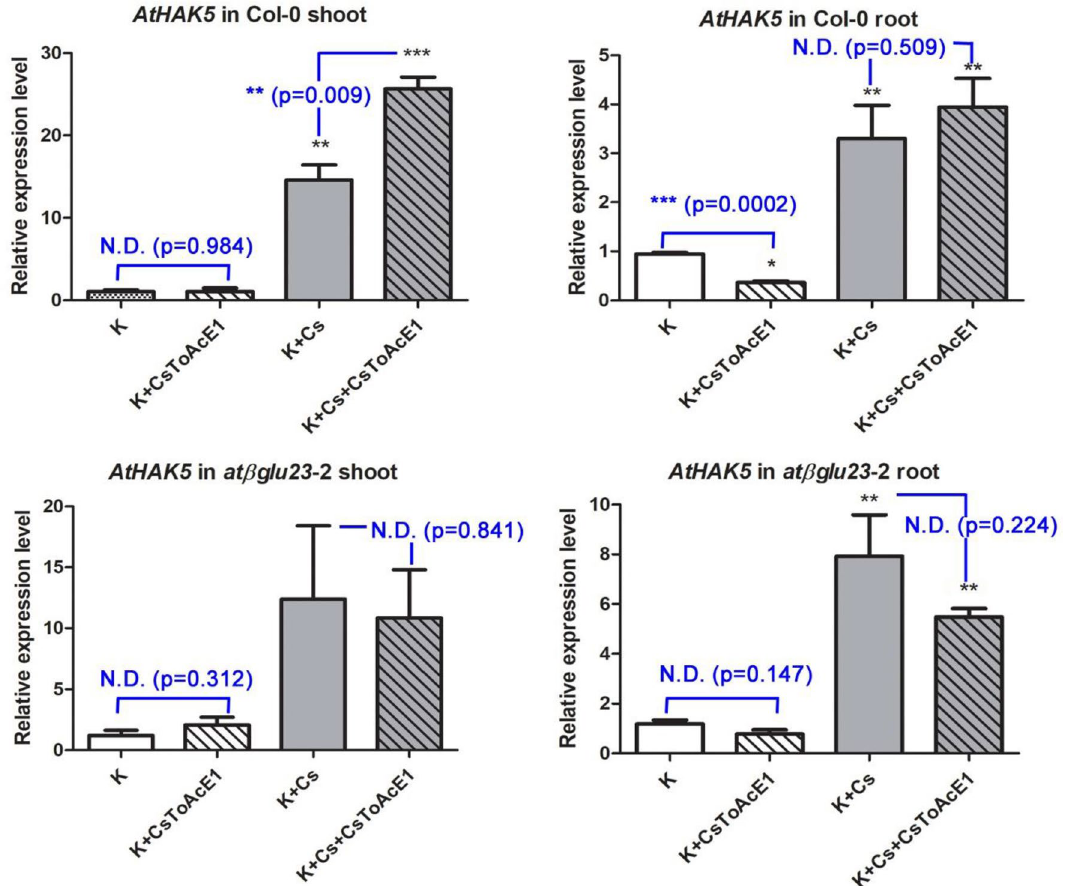
Figure 5. Analysis of AtHAK5 expression. The relative expression of AtHAK5 determined in 8-day-old Col-0 shoot and atβglu23 -2 root samples in response to 25 µM CsToAcE1, Cs, or a combination of Cs and CsToAcE1. The expression of AtHAK5 was used as a marker for K deficiency in planta . Error bars indicate standard errors (n = 3). Statistical differences relative to a control (K) were determined using a one-way ANOVA followed by a Tukey’s comparisons test and statistical differences between no CsToAcE1 treated and CsToAcE1 treated were determined using student t-tests (N.D., no difference; * p < 0.05; ** p < 0.01; *** p <